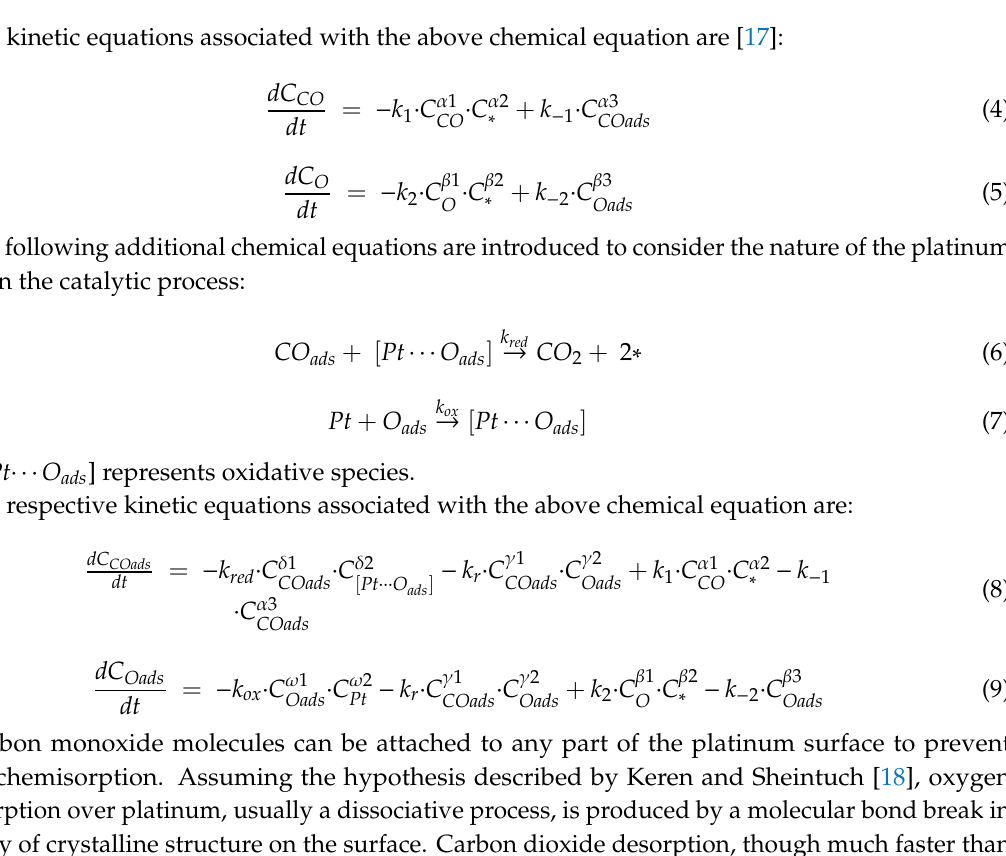
Figure 1. Essential mechanism of CO 2 formation.